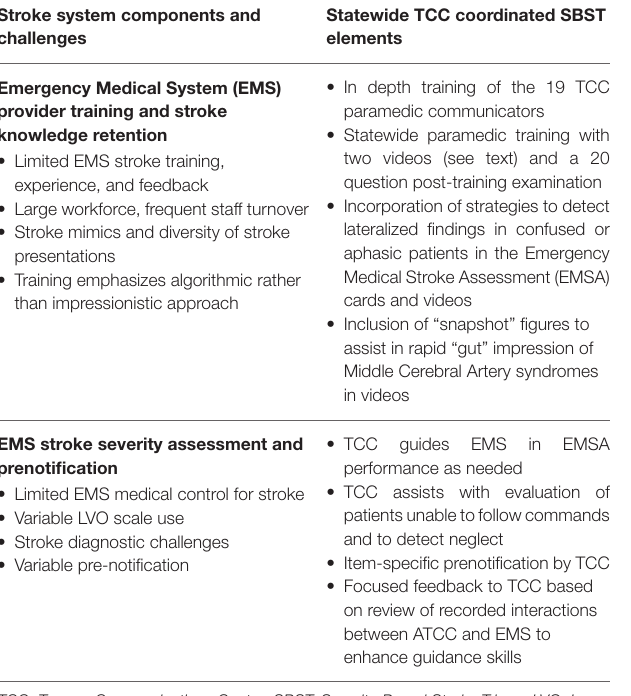
TABLE 1 | Acute stroke system challenges and statewide TCC coordinated SBST elements.